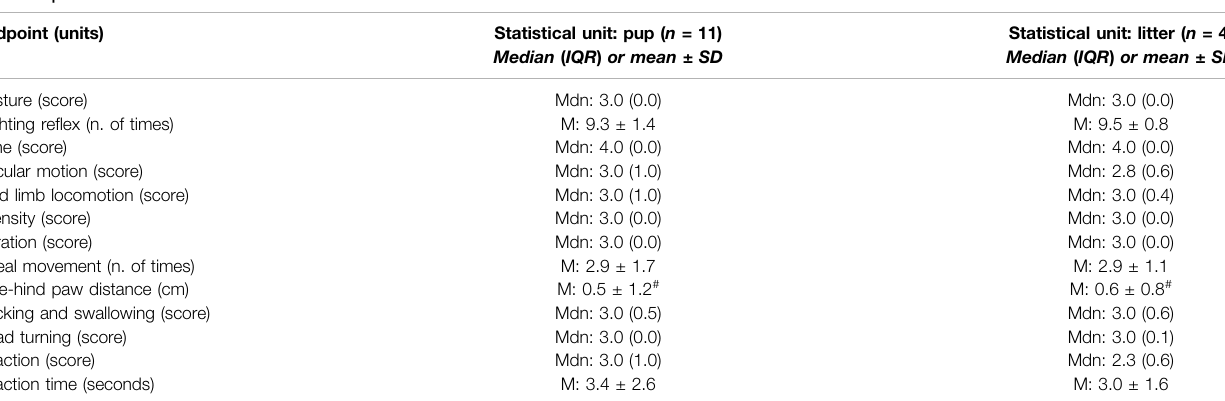
TABLE 5 | Results of PROTOCOL 4.